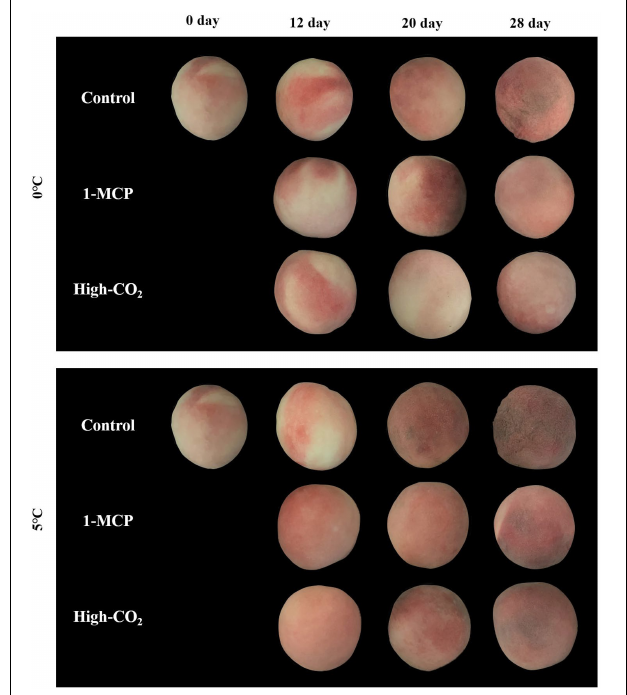
FIGURE 5 | Madoka peach fruit at harvest (0 day) and during storage up to 28 days at 0 and 5 ◦ C with or without prestorage treatment of 1-MCP and high CO 2